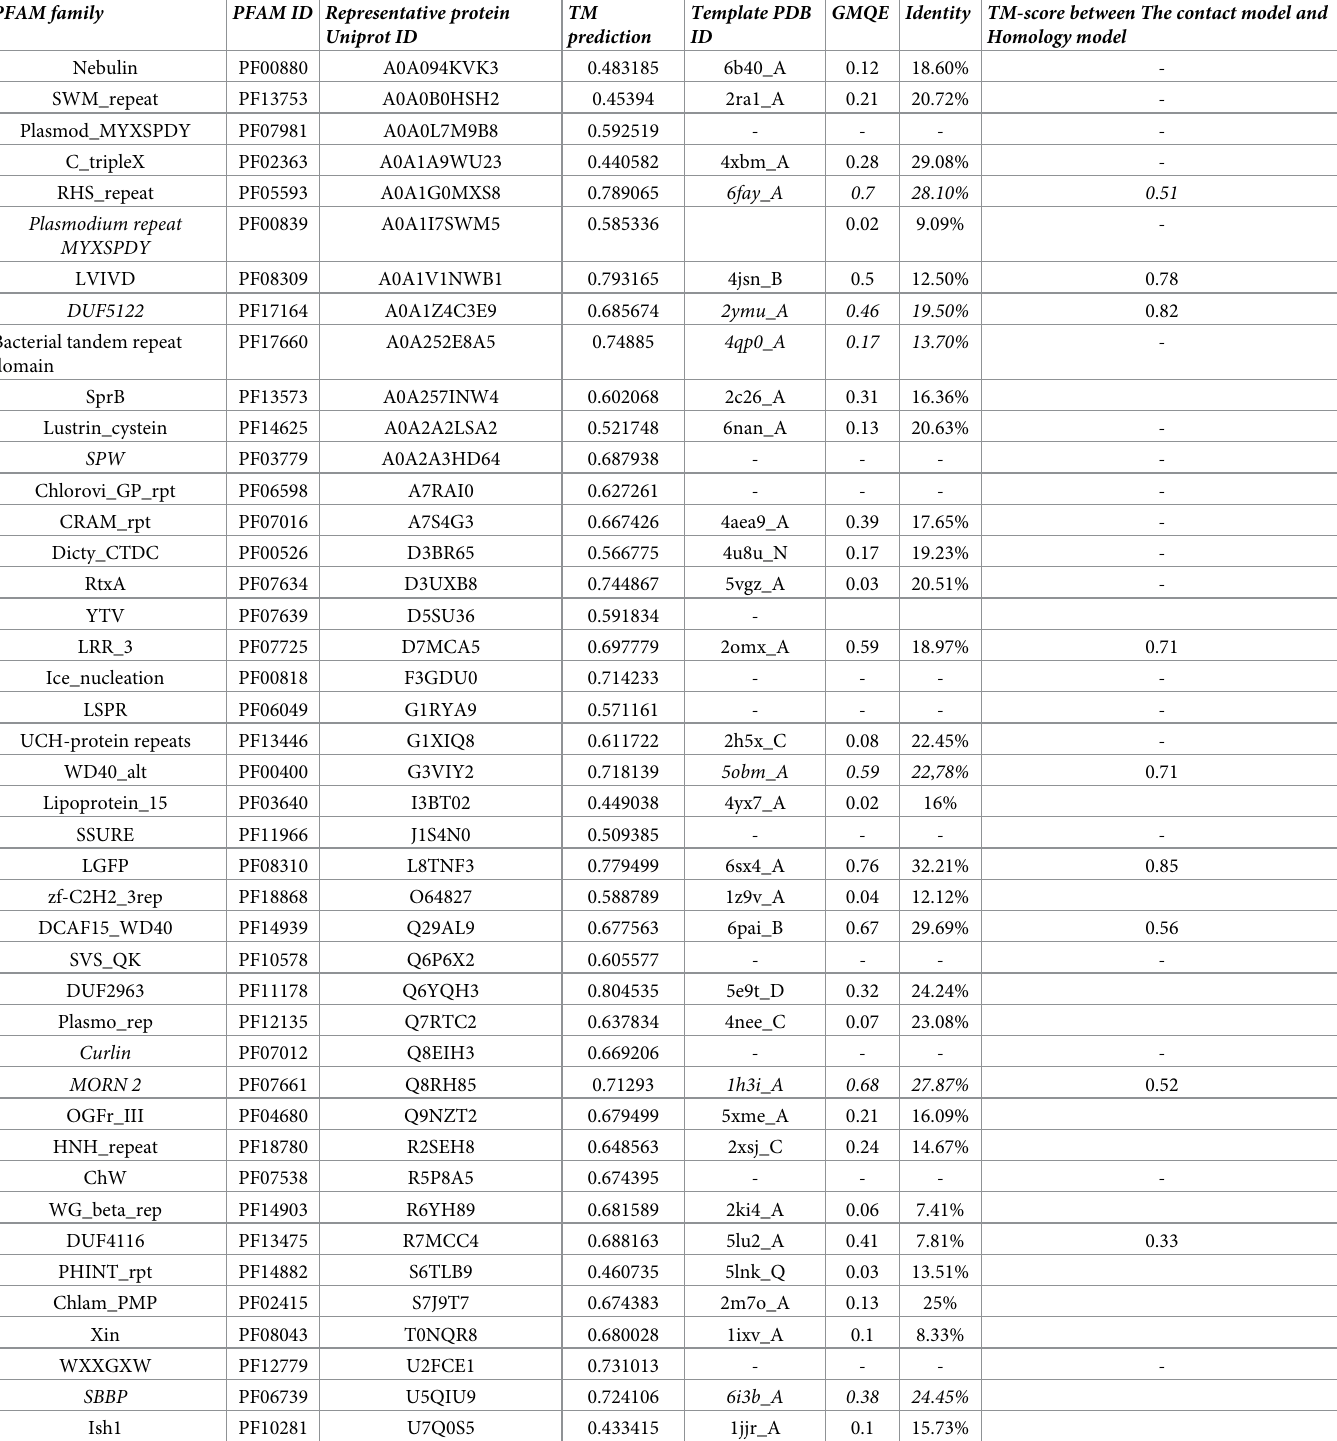
Table 1. The models of the PFAM families with predicted TM-score. In the columns: the family name, the PFAM ID, the Uniprot ID of the sequence used for the modelling, the predicted TM-score, the best template PDB ID, the Swismodel GMQE score, the identity between the target/template alignment, the TM-score between the contact-based model and the homology